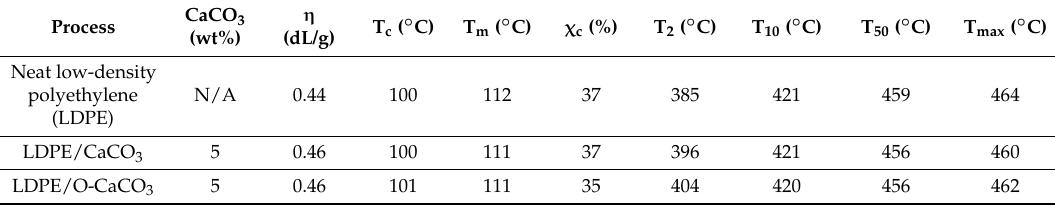
Table 1. Thermal properties of polyethylene (PE)/CaCO 3 nanocomposites before photoaging.